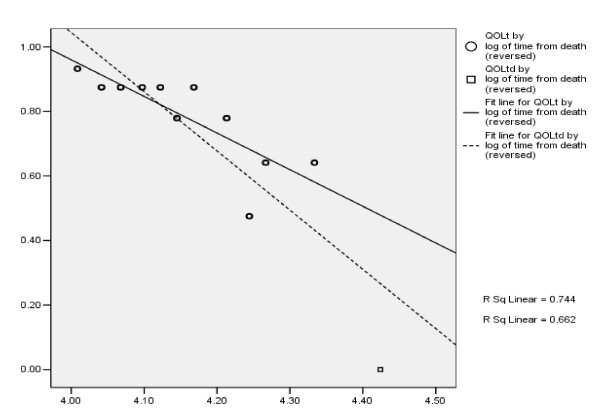
Imputation regression for "Mr. Smith".